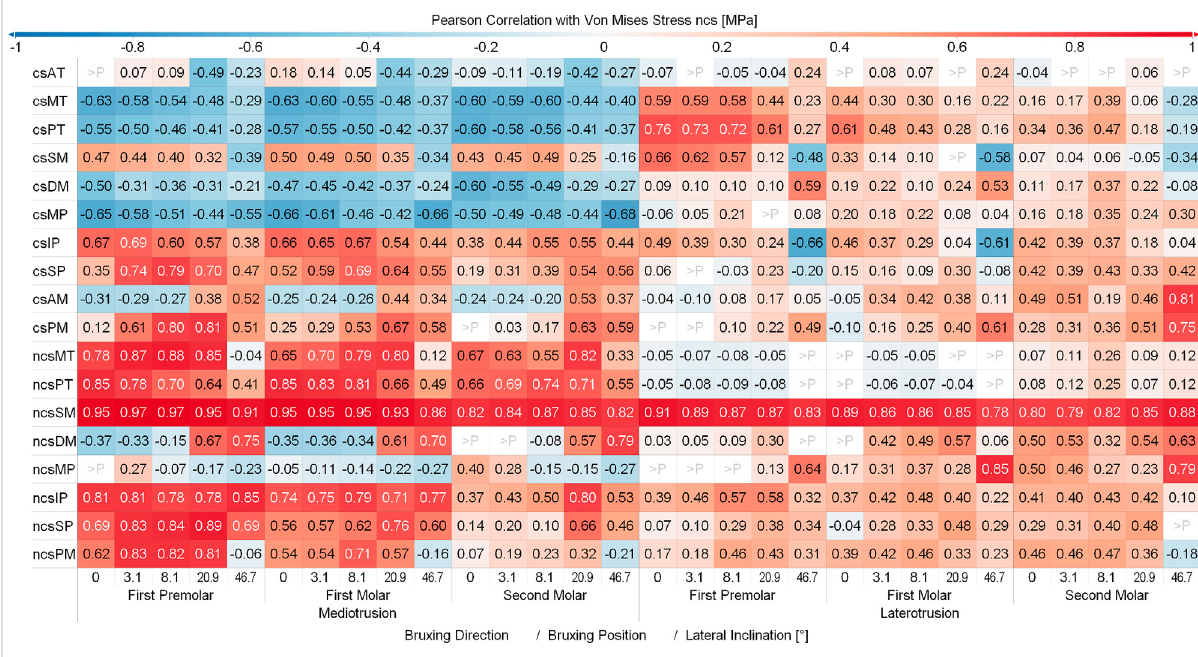
FIGURE 7 Correlation between muscles and non-contact side disc von Mises stress. Y-axis shows muscles with a mean activation > 20%; contact (cs) and non-contact side (ncs); AT, anterior part of temporalis; MT, medial part of temporalis; PT, posterior part of temporalis; SM, super fi cial head of the masseter; DM, deep head of the masseter; MP, medial pterygoid; IP, inferior head of lateral pterygoid; SP, superior head of lateral pterygoid; AM, anterior mylohyoid; PM, posterior